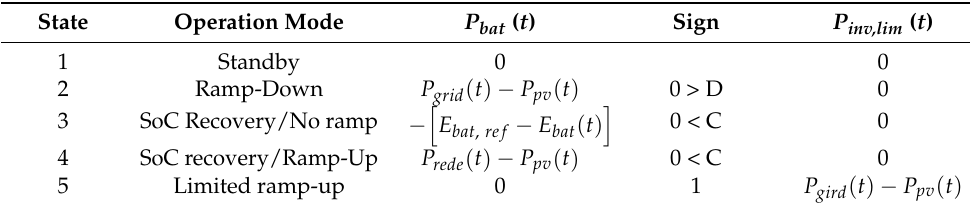
Table 2. Operation modes of Strategy 1.